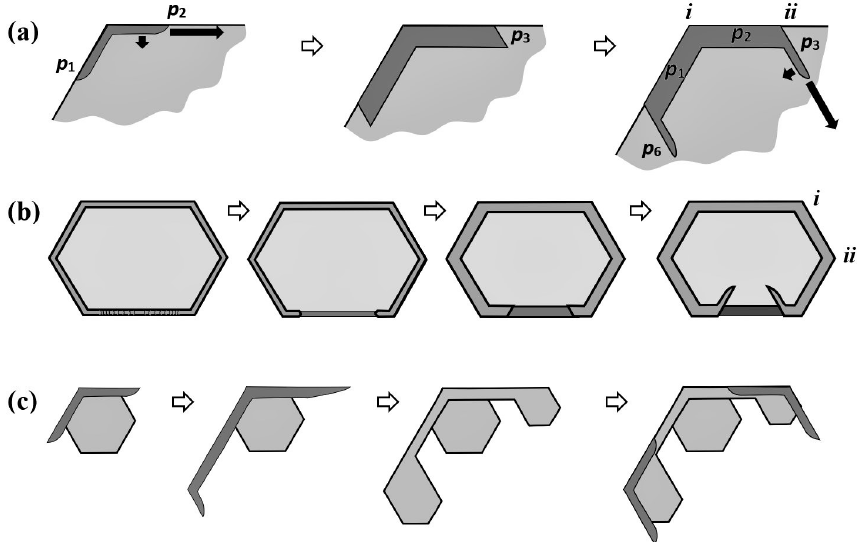
Figure B11. Scroll and sheath bundles via protruding and normal growth. (a) The basic process, viewed along c axis (normal to basal). The darker region is a sheath protrusion from prisms p 1 and p 2 going up out of the page. Arrows indicate relative rates of growth in width (via AST) and thickness (via normal growth). In middle sketch, protruding region has thickened, slowing the rate of protruding growth and allowing significant lateral growth on the ends that leads to new prism facets p 3 and p 6 . In the right sketch, protrusion growth occurs on these new prism faces. The process can continue (not shown), generating facets p 4 and p 5 . Compare i and ii vertices to ones in Fig. B10. (b) A complete sheath has its rim broken at the bottom (left), due to a vapor-density gradient or asymmetry. The process in the next three sketches follows the same process as explained in (a) . Vertices i and ii correspond to those in Fig. B10. (c) Possible source of sheath and needle bundles from protruding growth. Leftmost sketch follows from start of case (a) except protruding growth overshoots the base. (Overshooting is exaggerated to clarify the concept.) In middle sketches, the edge of the protrusion thickens and facets as in case (a) . Far right: process repeats.